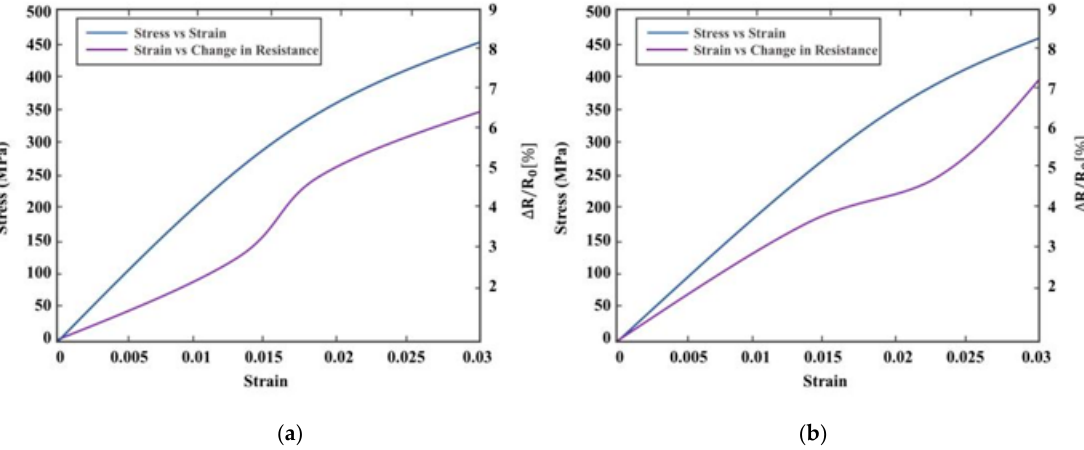
Figure 13. Glass fiber-reinforced SWCNTs: ( a ) non-aligned nanotubes and ( b ) aligned SWCNTs.